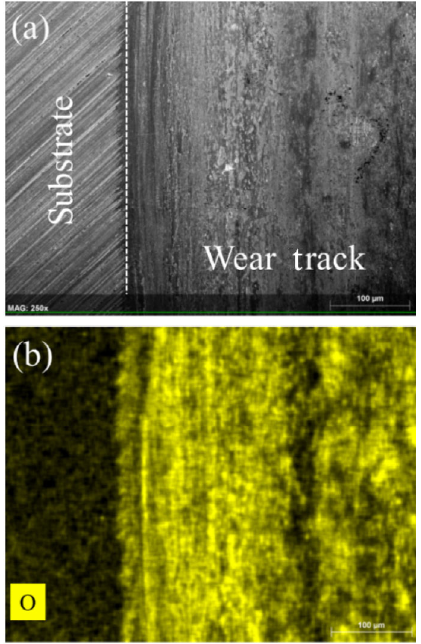
Fig. 6 (a) SEM image and (b) oxygen distribution of wear track lubricated by base